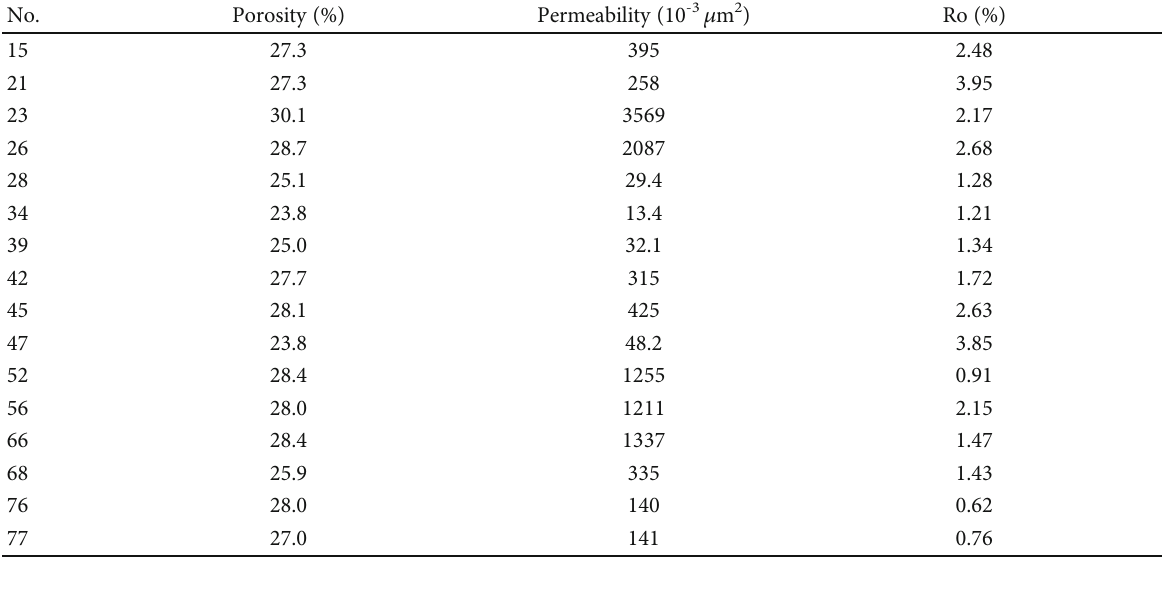
Table 9: Saturation ( S ) and Ro of samples.